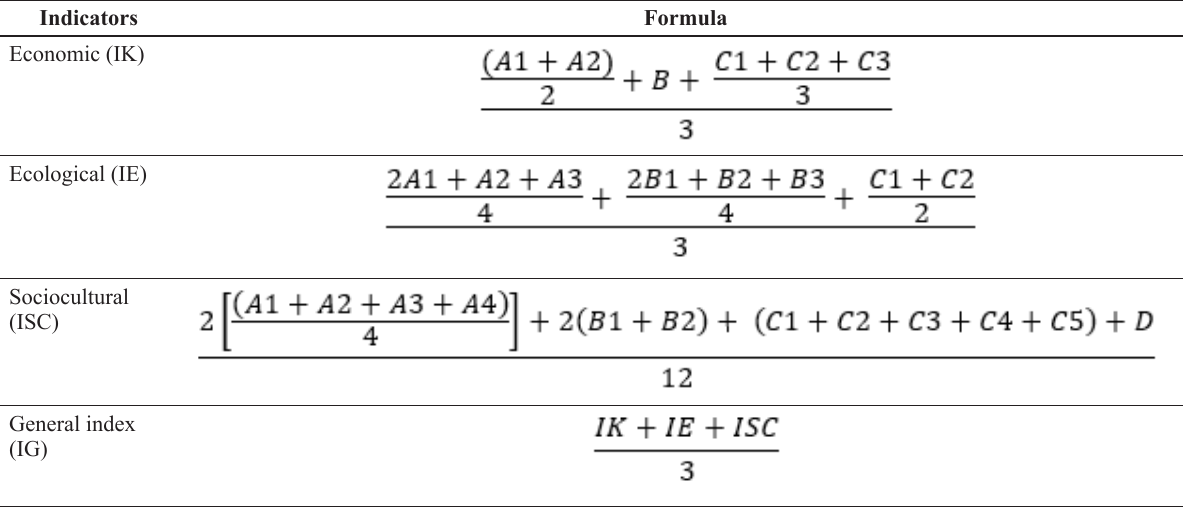
Table 4: Sustainability calculation formulas and general index